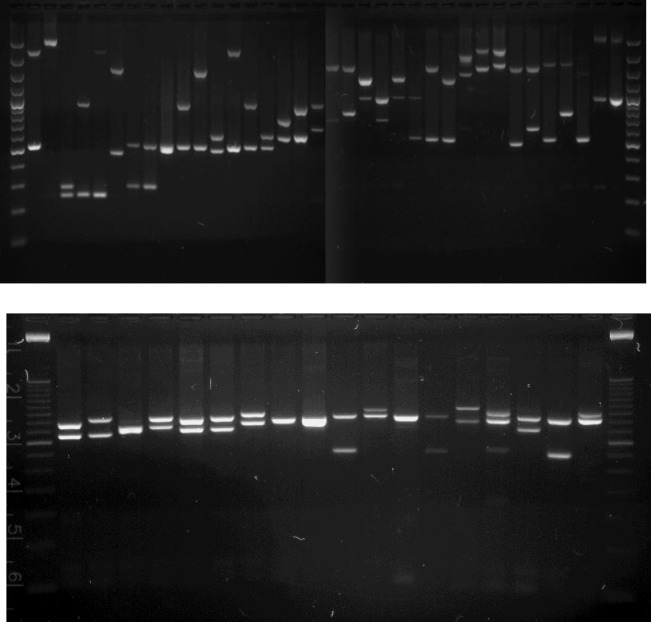
(a) Agarose gel showing amplification products of second intron sequences. First and last lane is the 100 bp size standard. (b) Agarose gel showing amplification products of first intron sequences. First and last lane is the 50 bp size standard